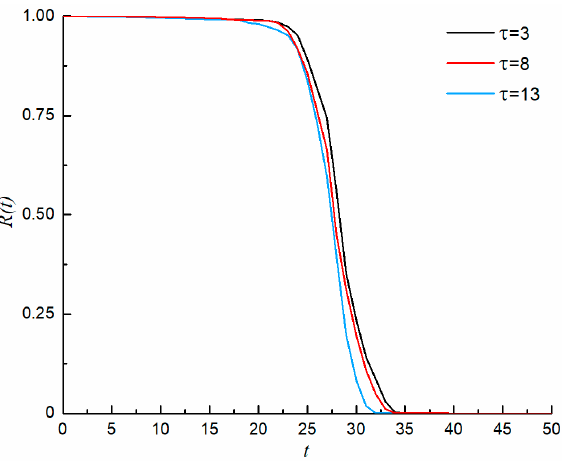
Figure 5. Reliability curves with varying interval thresholds of self-recovery.